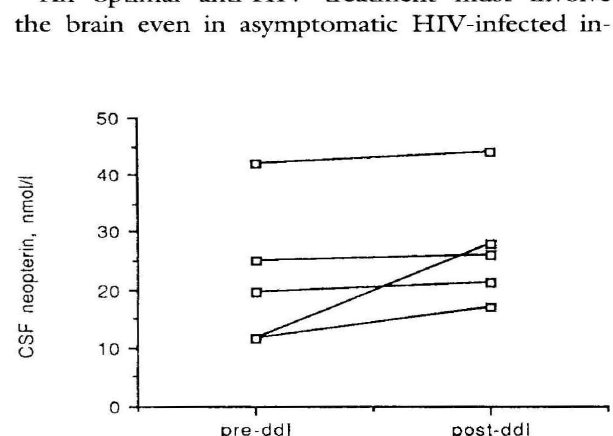
Figure 3. Concentrations of neopterin in cerebrospinal fluid before, and after 5 to 12 months on, didanosine (ddJ) treatment in 5 HIV-positive patients without neu rological